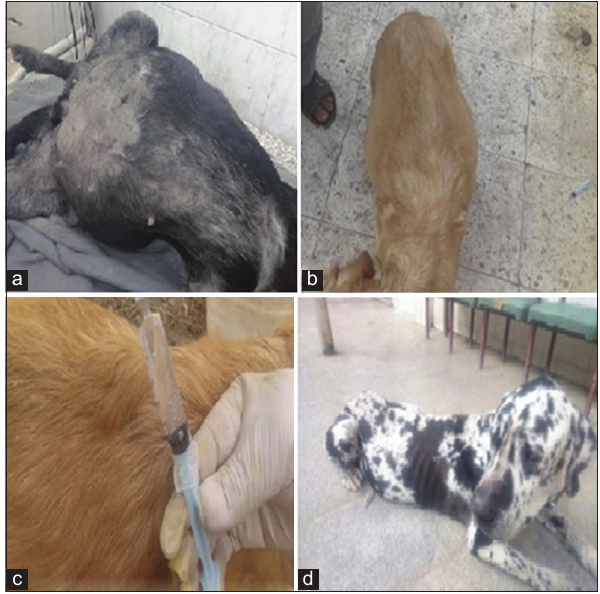
Figure-2: Clinical manifestations in Group B (chronic hepatitis): (a and b) Distension of abdomen with fluid (ascites). (c) Aspiration of abdominal fluid revealed clear transudate. (d) Severe weight